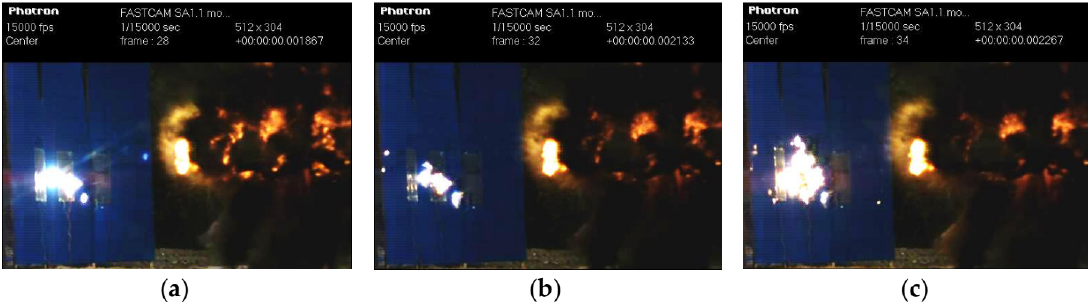
Figure 6. High-speed photography record of the D-90 ◦ experiment I. ( a ) 2# target plate ( t = 1.87 ms);